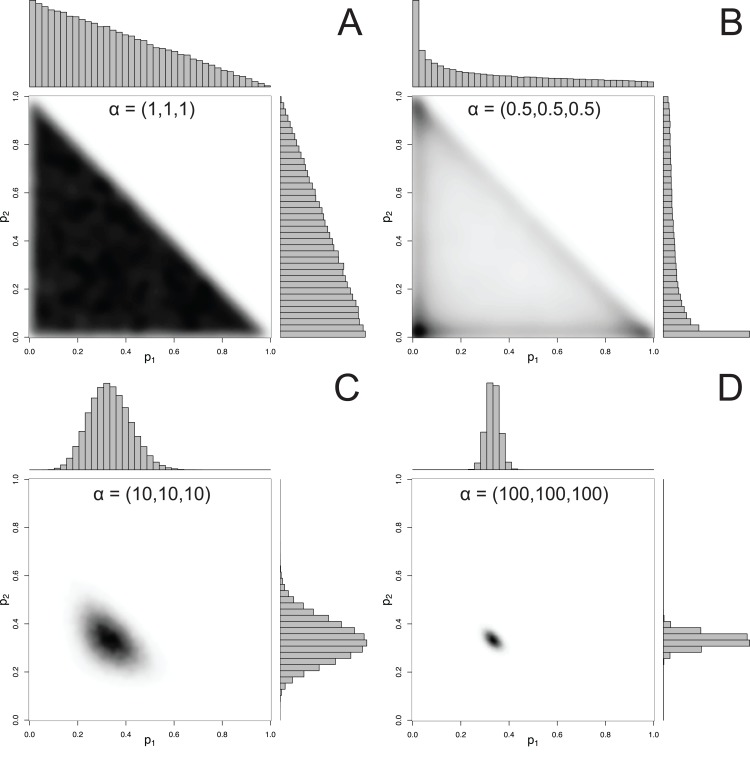
Examples of joint and marginal distributions of p1 and p2 for a three-component Dirichlet distribution, across 4 sets of hyperparameters.(A) α = 1, (B) α = 0.5, (C) α = 10, and (D) α = 100. All simulations were done with the “rdirichlet” function in the “compositions” library in R (Van Der Boogaart & Tolosana-Delgado, 2006).